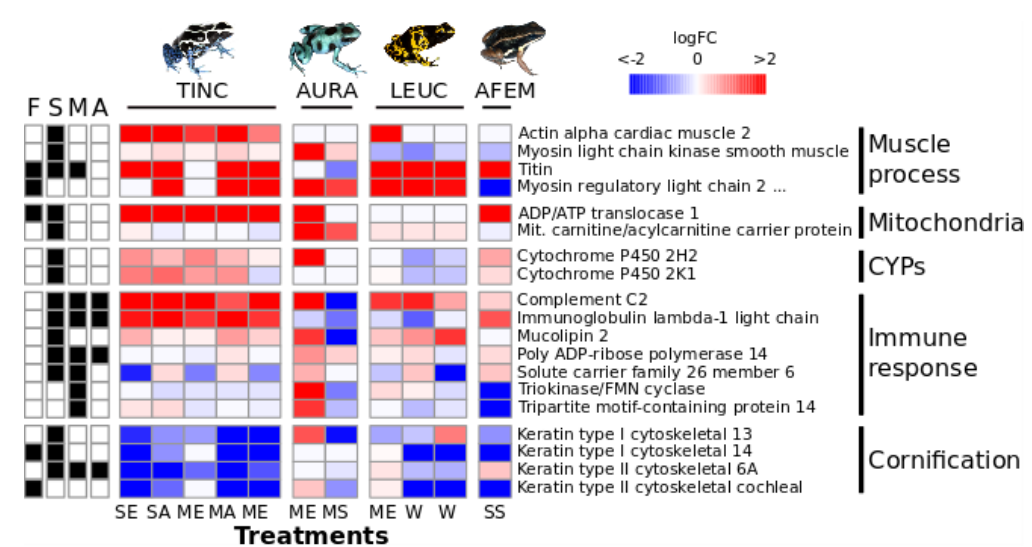
Figure 3. LogFC of genes of interest found across species. Species on the top: TINC = D. tinctorius , AURA = D. auratus , LEUC = D. leucomelas, AFEM = A. femoralis. Treatments on the bottom: SE = single-dose epibatidine, SA = single dose alkaloid mixtures, ME = multi-dose epibatidine, MA = multi-dose alkaloid mixture, MS = multi-dose sparteine, W = wild. On the left, we indicated, with a box filled black, the approaches used to identify each gene. Approaches: F = filtering by expression pattern, S = single-dose vs control results for D. tinctorius , M = multi-dose vs control results for D. tinctorius, A = alkaloid (i.e., single-dose and multi-dose) vs control results for D. tinctorius . On the right, genes have been grouped according to their broad biological significance. For visualization, this heatmap has a ceiling of logFC ± 2. LogFC values are given in